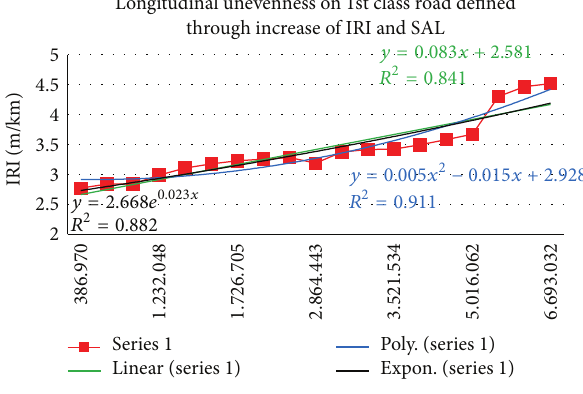
Figure 6: IRI deterioration for 1st class roads.